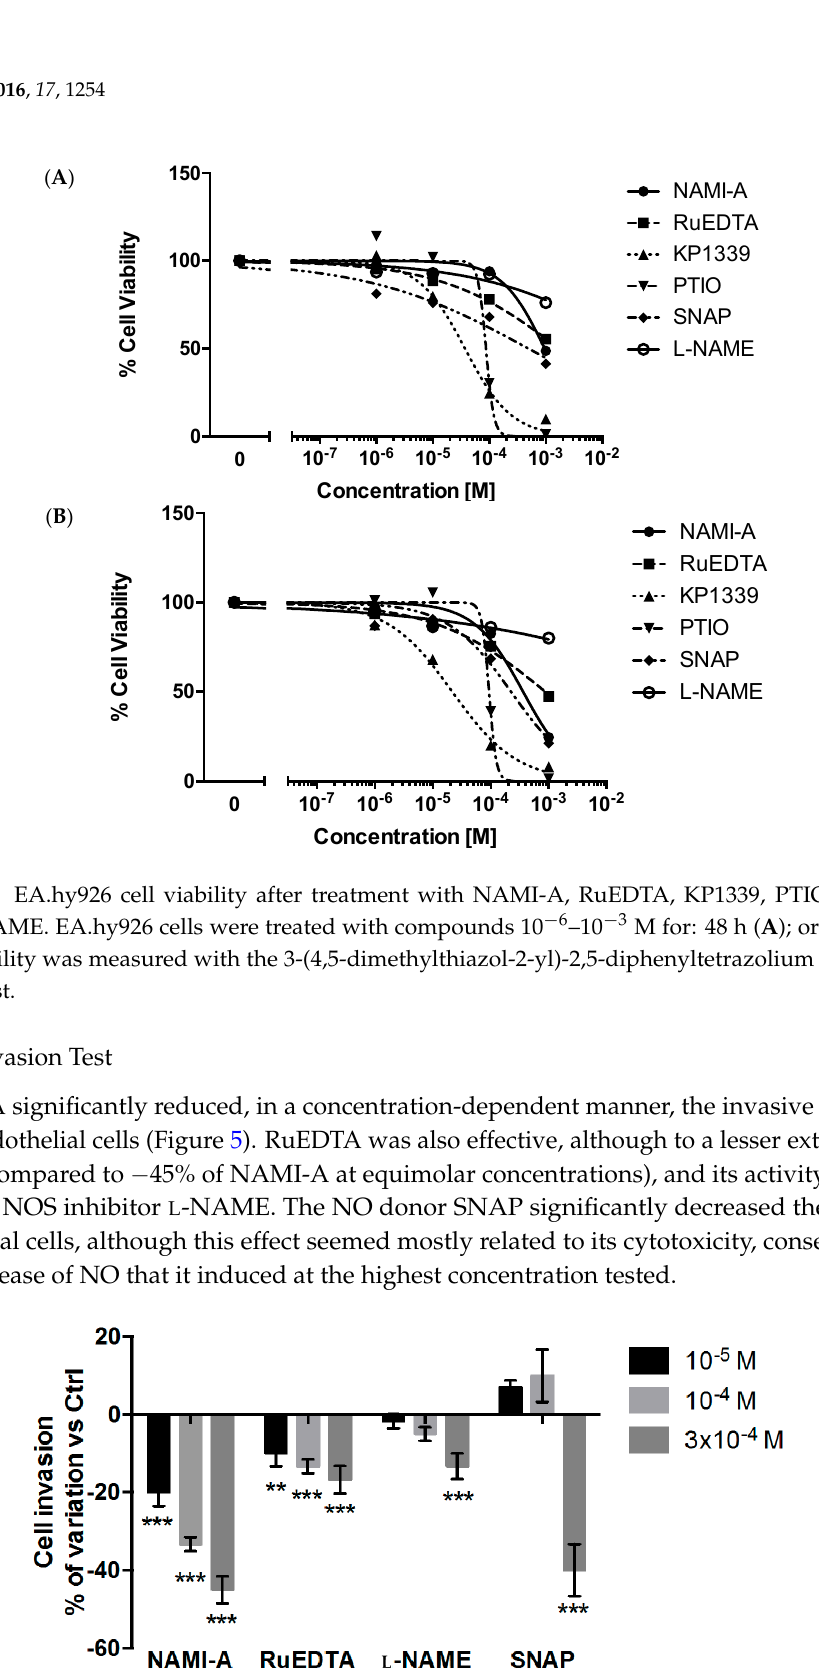
Figure 5. Effects of NAMI-A, RuEDTA, L -NAME, and SNAP on the invasive ability of EA.hy926 cells. EA.hy926 cells were treated with compounds at 10 − 5 , 10 − 4 , and 3 × 10 − 4 M for 24 h before seeding them on Transwell ® filters. Cell invasion was detected after further 24 h at 37 °C 5% CO 2 . Data are expressed as per cent of variation vs. the controls and are the mean ± S.E.M. of three samples per group. ANOVA and Tukey–Kramer: ** p < 0.01, *** p < 0.001 vs. Control.